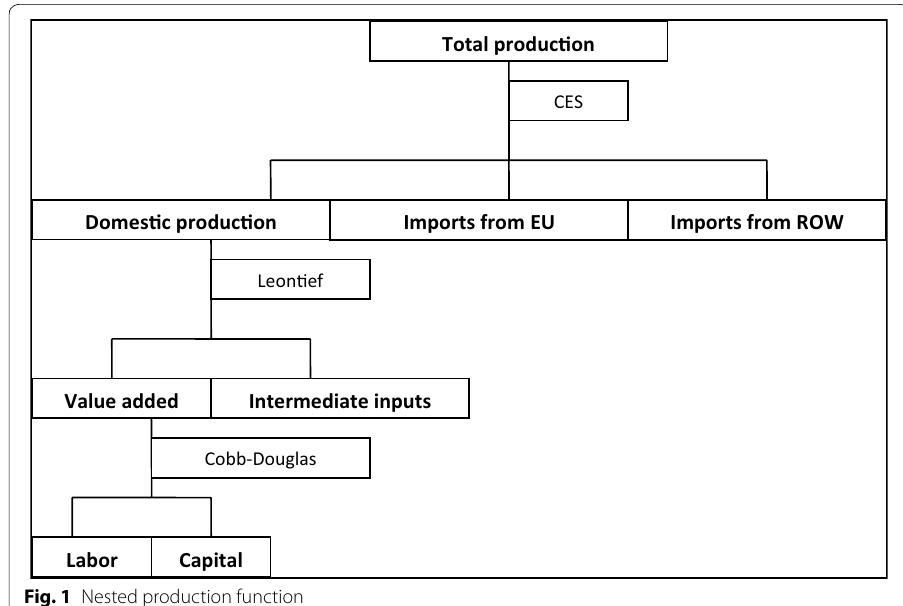
Fig. 1 Nested production